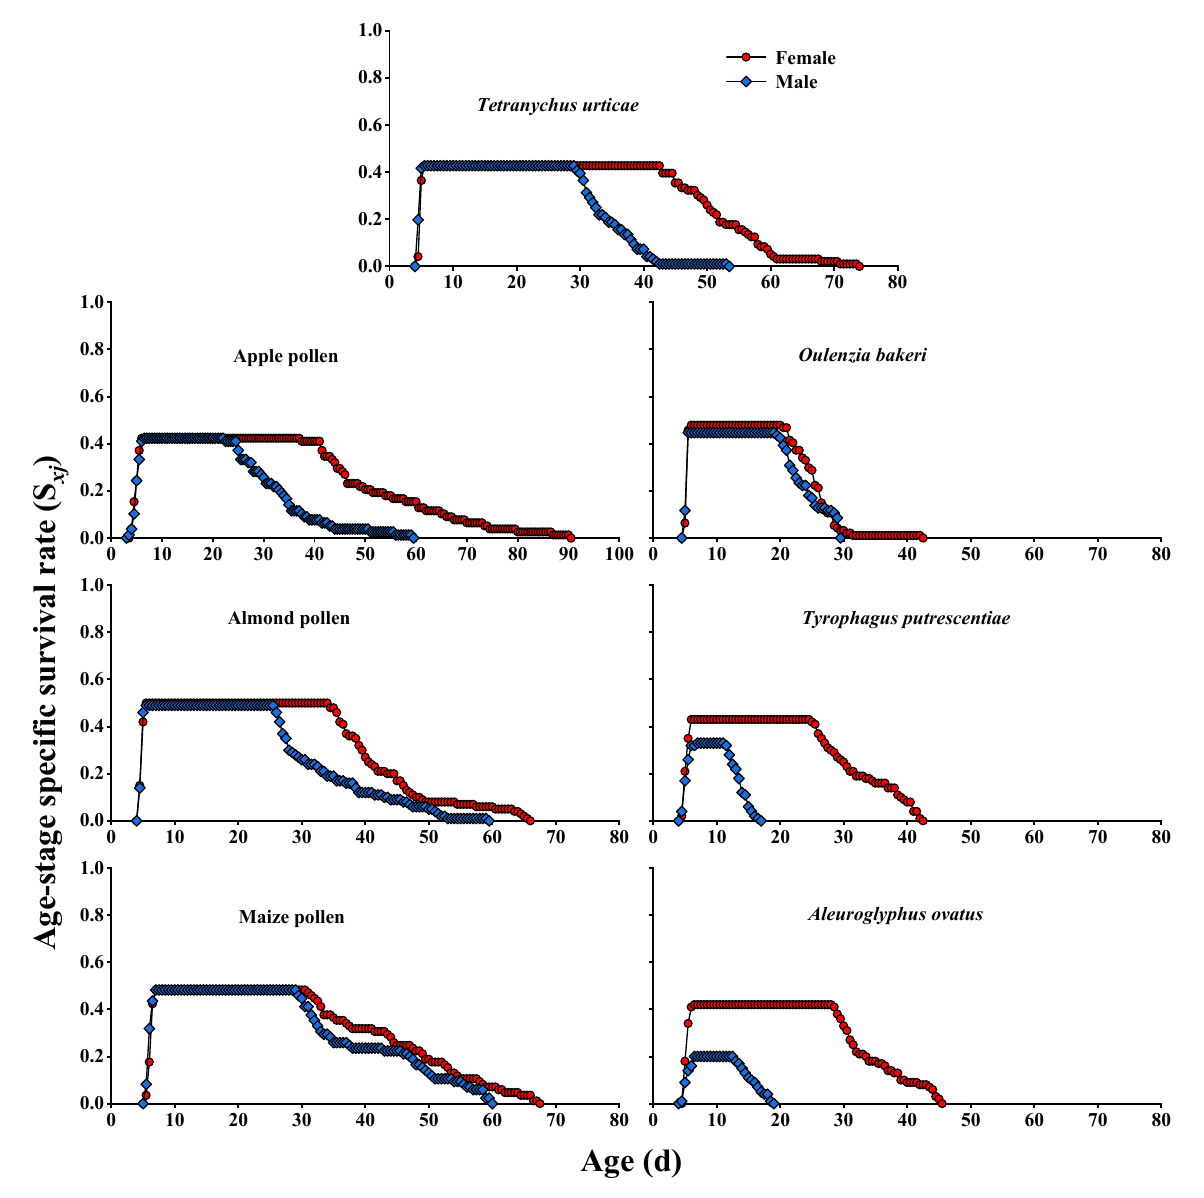
Figure 2. Age–stage-specific survival rate ( S xj ) of adult stages of A. herbicolus on six alternative foods and its natural prey, T. urticae .